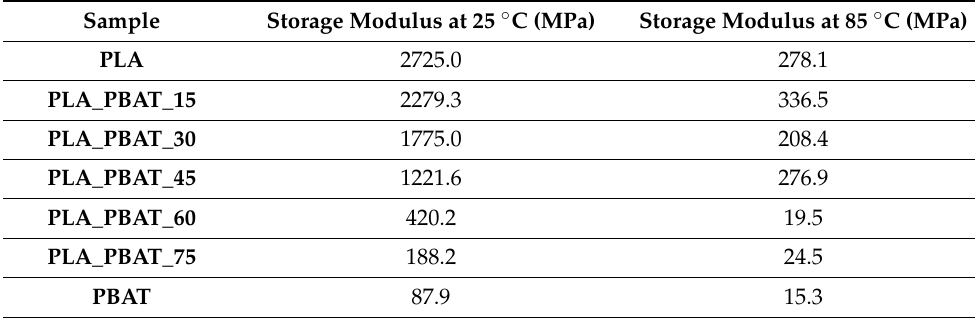
Figure 7. Storage modulus ( a ) and loss modulus ( b ) of neat PLA, neat PBAT and PLA/PBAT blends. Table 4. Results of the DMA tests on the prepared blends.